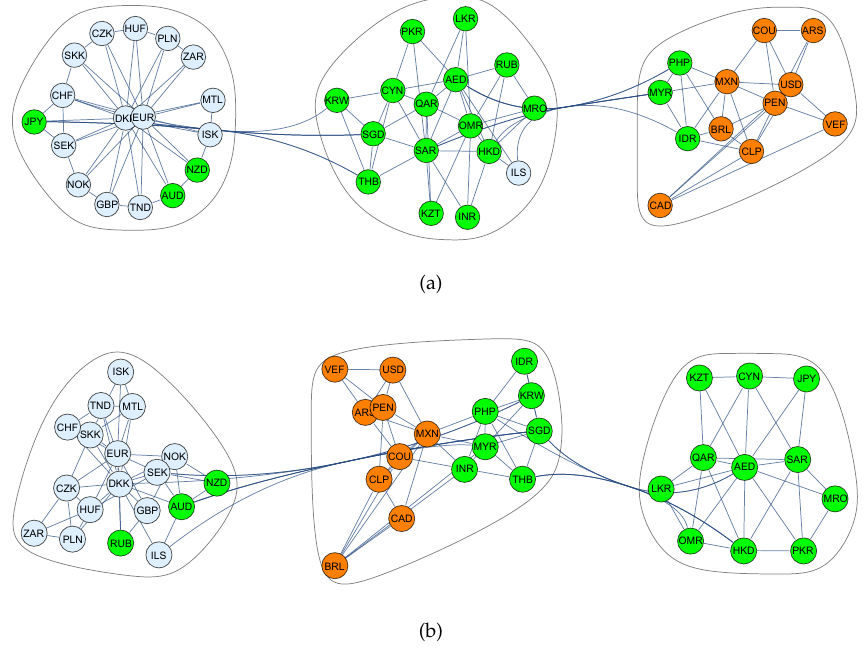
Figure 6. Planar maximally filtered graph (PMFG) for the foreign exchange markets obtained using lagged correlations during ( a ) the economically calm period and ( b ) crisis period. The currencies are denoted by their three-letter symbols and color-coded according to their geographical locations: green for Asia, light blue for Europe, orange for the Americas. For lagged correlations we use time t for the Americas and time t + 1 for Europe and Asia. During both periods, we detect three large clusters. In the non-crisis period we observe that the clusters are determined by the geographical currency location, except for the Japanese yen, New Zealand dollar and Australian dollar. Iceland appears in the predominantly Asian cluster, while Malaysia, the Philippines and Indonesia are part of the American community. During the crisis period the interconnectedness between American and South East Asian currencies increases as they belong to the same community. The purely Asian cluster comprises the Japanese Yen along with the currencies of the oil-exporting countries. The Russian ruble joins the European